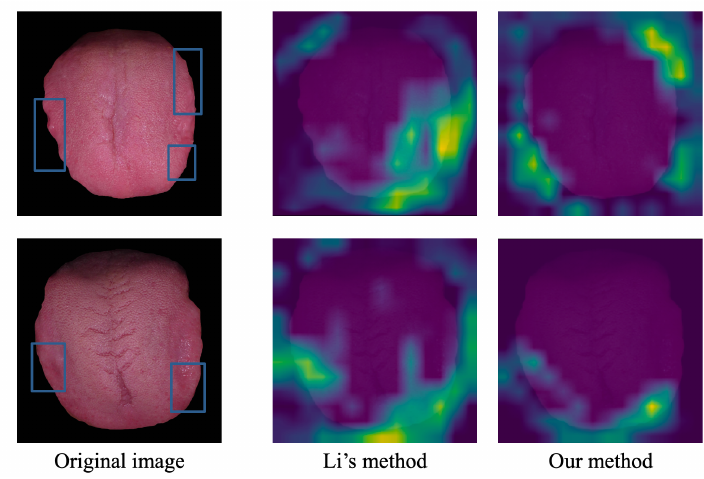
Figure 5. Grad-CAM explanations for Li’s method and our method. We can see that, even though both methods made the right decision, these two models are different in their attention.